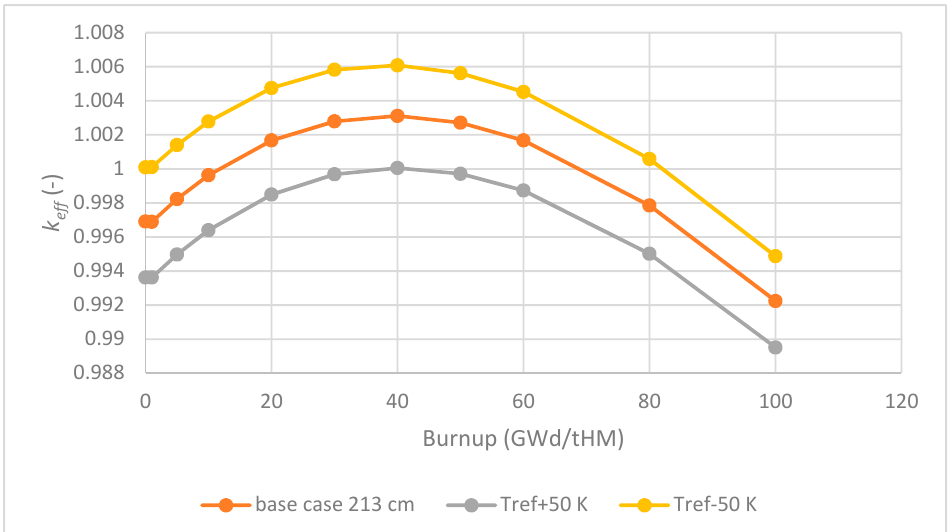
Figure 4. Criticality of the 2D system over burnup for the nominal case with 980 K and cases with reduced and increased system temperature for the close to eutectic composition 45%NaCl-38.5%UCl 4 - 16.5%UCl 3.